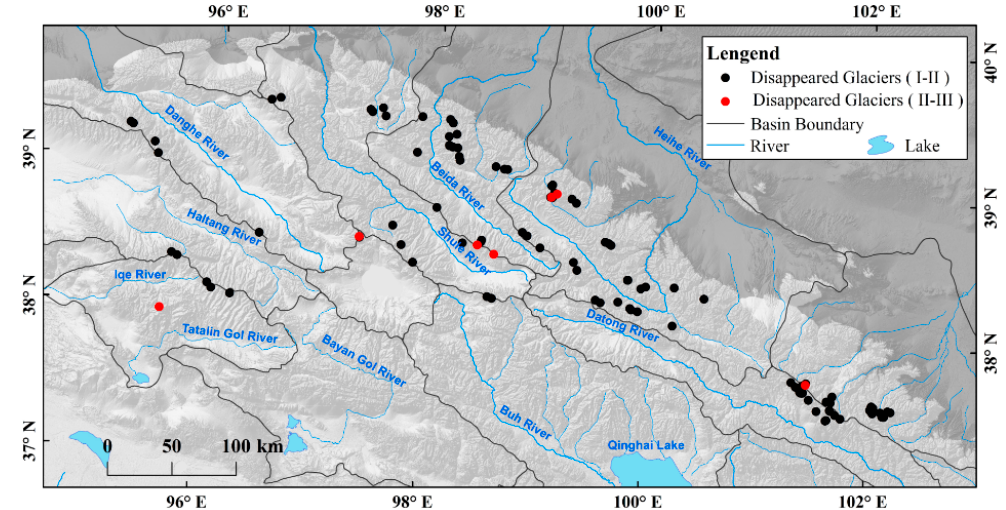
Figure 10. The location of disappeared glaciers from the 1960s to 2015.